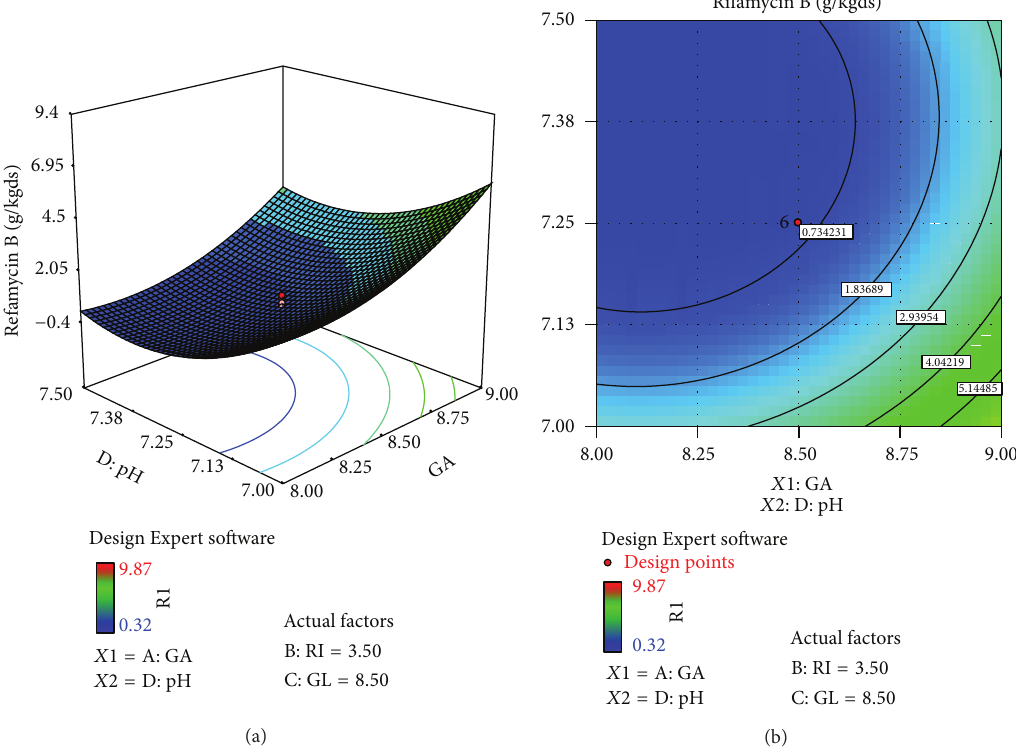
Figure 9: Surface and contour plot for rifamycin B production at varying levels of 𝑋1 , galactose (GA), and 𝑋10 , pH.